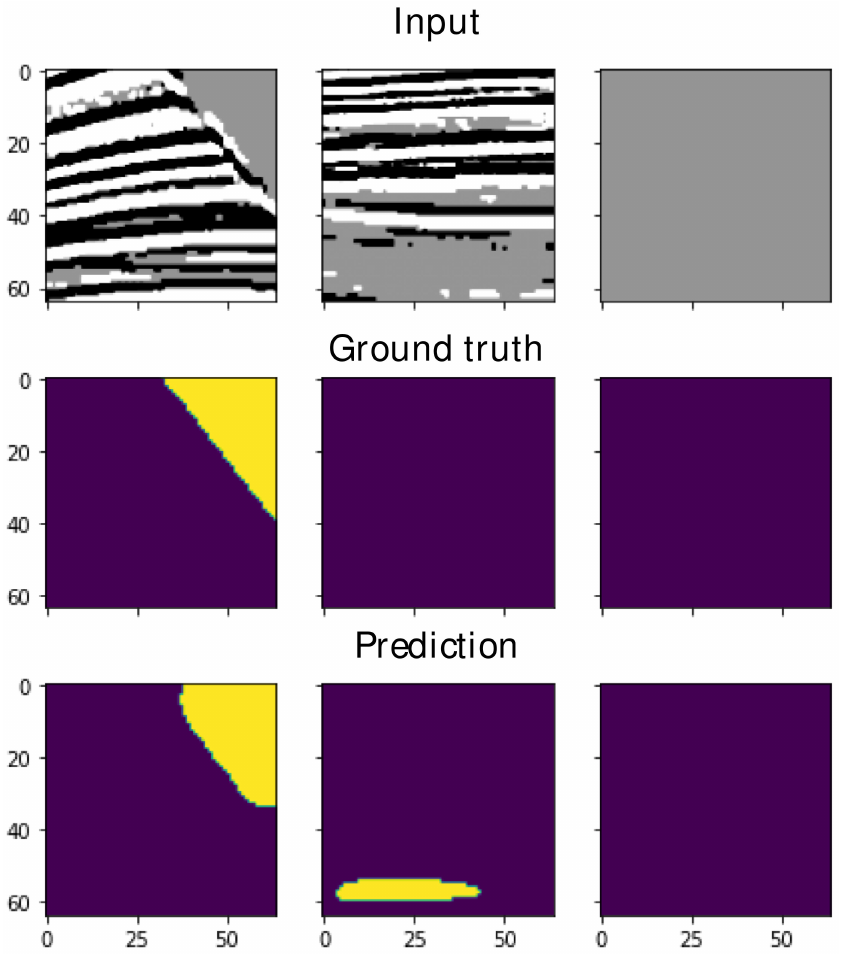
Figure 16. The predicted result on the validation data. After training the optimum model, we applied this model to the whole seismic data. We divided the entire seismic into 64 × 64 × 64 patches to feed into the model, and then concatenated the predicted patches back into the original size. Figure 17 shows the predicted result with a 2D seismic section display. As we can see, the predicted result gives an outstanding detection of salt bodies on the seismic data. The inline sections (Figure 17a) show the accurate salt feature detection. However, there is also a noisy and misclassified both for crossline and time-slice seismic section (Figure